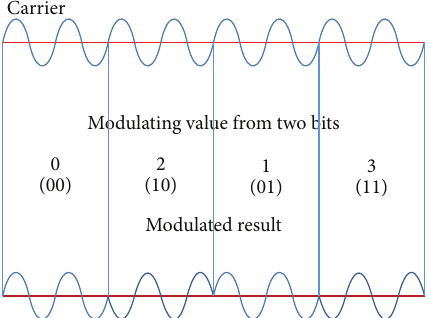
Figure 2: QPSK modulated waveform: the signal on the in-phase armismultipliedbycosinecomponentandthesignalonthequadra- ture arm is multiplied by sine component.